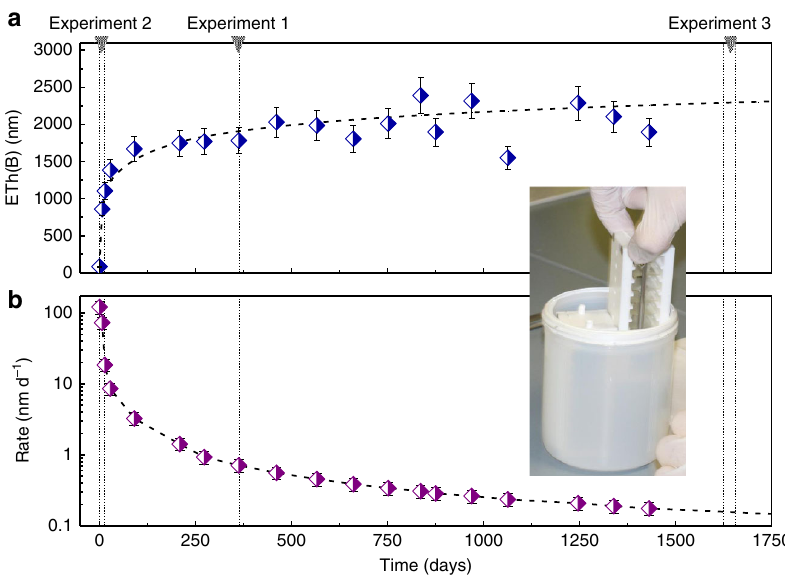
Fig. 1 Experiment from which pieces studied in experiment 1 and 3 were taken. This initial experiment was conducted in the so-called “ reference conditions ” (90 °C, pH 90°C 7, 160 mg L − 1 of Si and 6 g L − 1 of K). The image displays the reactor, the sample holders, and a few glass pieces. More details are provided in Gin et al. 14 . Experiment 2, although conducted on new fresh glass pieces corresponds to the early stages of the initial experiment. a Time evolution of the equivalent thickness of altered glass calculated from B concentration in solution. A few data points deviate from the overall trend because of the low concentration of B and the high dilution factor ( ∼ 11) prior to ICP-OES analyses. b Glass dissolution rate derived from the correlation displayed in a . Error bars represent